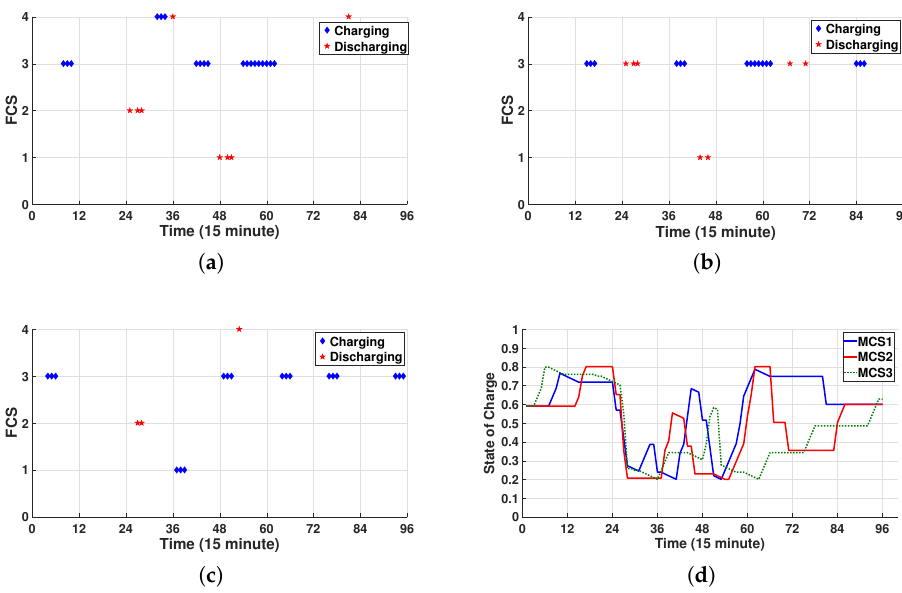
Figure 12. Spatial-temporal schedule for charging and discharging of MCSs. ( a ) Location of MCS1. ( b ) Location of MCS2. ( c ) Location of MCS3. ( d ) SOC for MCS1, MCS2, and